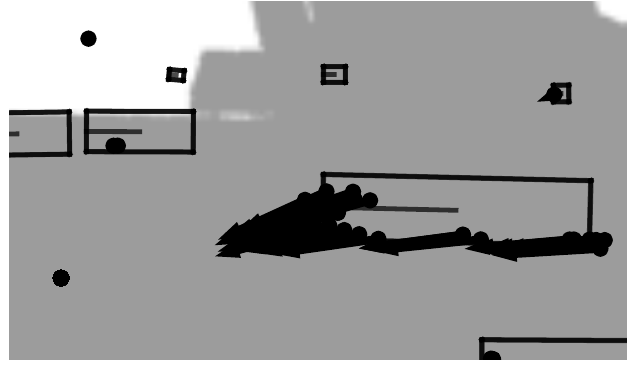
Figure 11. A bus approaching the sensor vehicle in BEV projection. The black color of the ground-truth points and bounding box indicates a static vehicle, despite the bus clearly approaching as indicated by its measured relative velocity. NuScenes sample token: 87a927d7e61345d3a098eb66908bddcb. The radar data is limited to 125 detections per sweep by the sensor